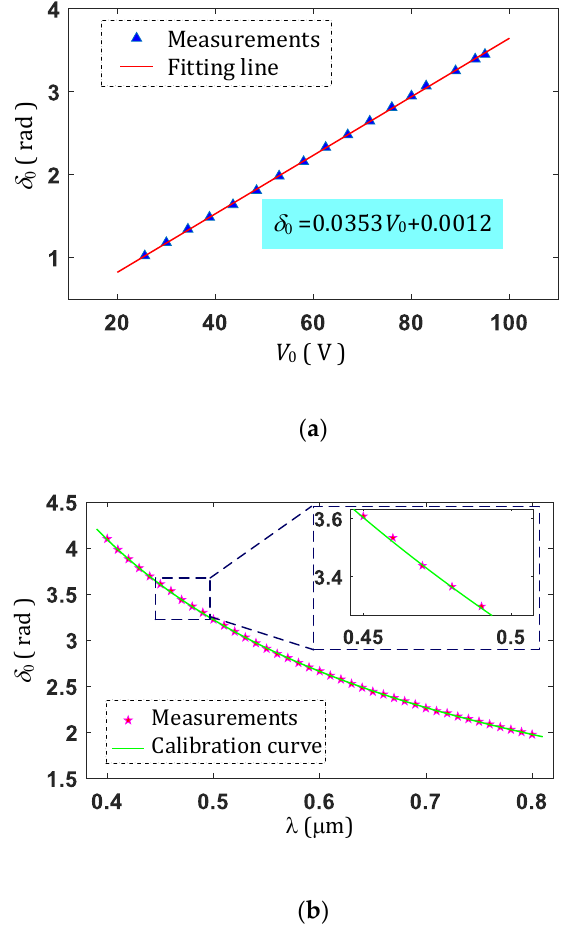
Figure 6. Calibration and measurement of δ 0 , ( a ) δ 0 vs. V 0 , at a wavelength of 0.532 µ m; ( b ) δ 0 vs. λ , the inset shows a magnification of the